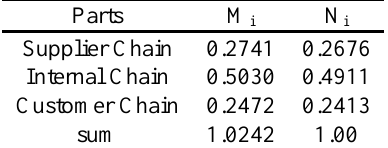
Table 8. Relative non-fuzzy and normalized weights of each part.